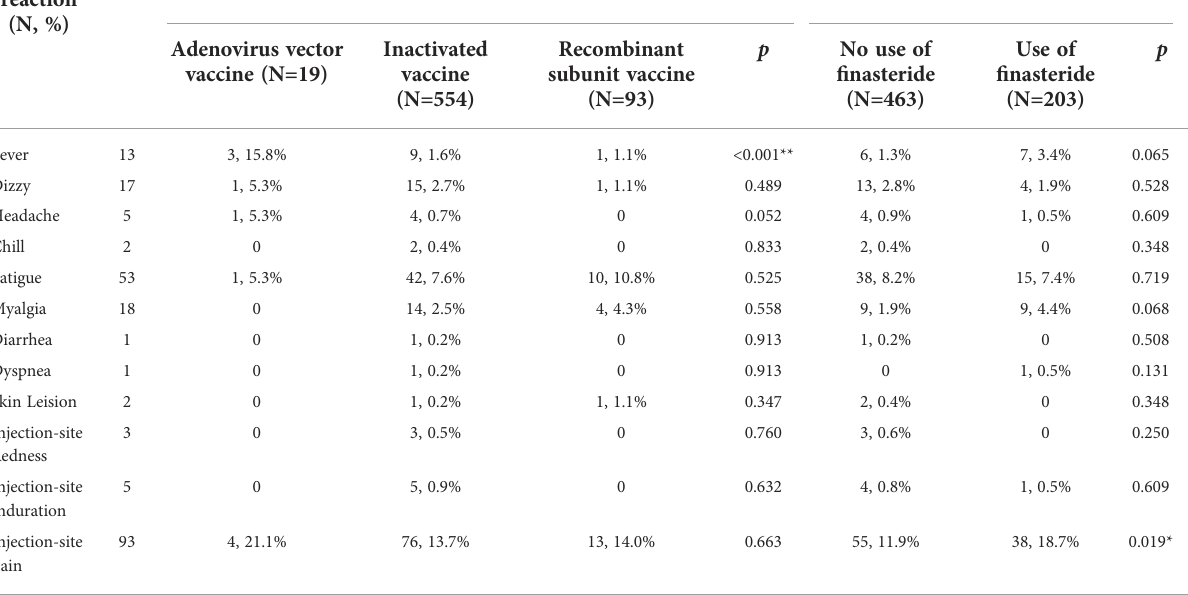
TABLE 5 Adverse reactions of vaccination by the vaccine types and the treatment among patients with androgen sensitive phenotypes (N=666). Adverse reaction (N, %)